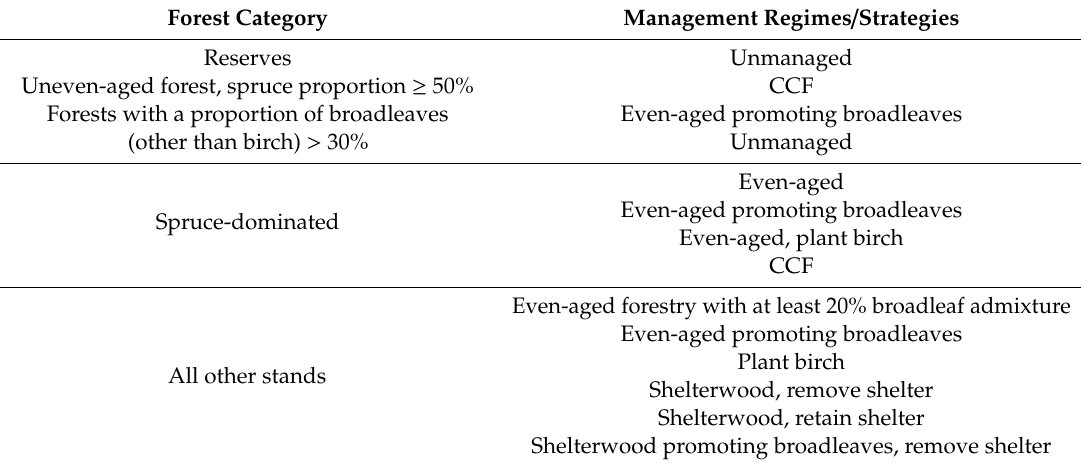
Table A3. Management strategies for di ff erent forest categories. For all strategies, a maximum number of 10 treatment schedules was created. Forest Category Management Regimes / Strategies Reserves Uneven-aged forest, spruce proportion ≥